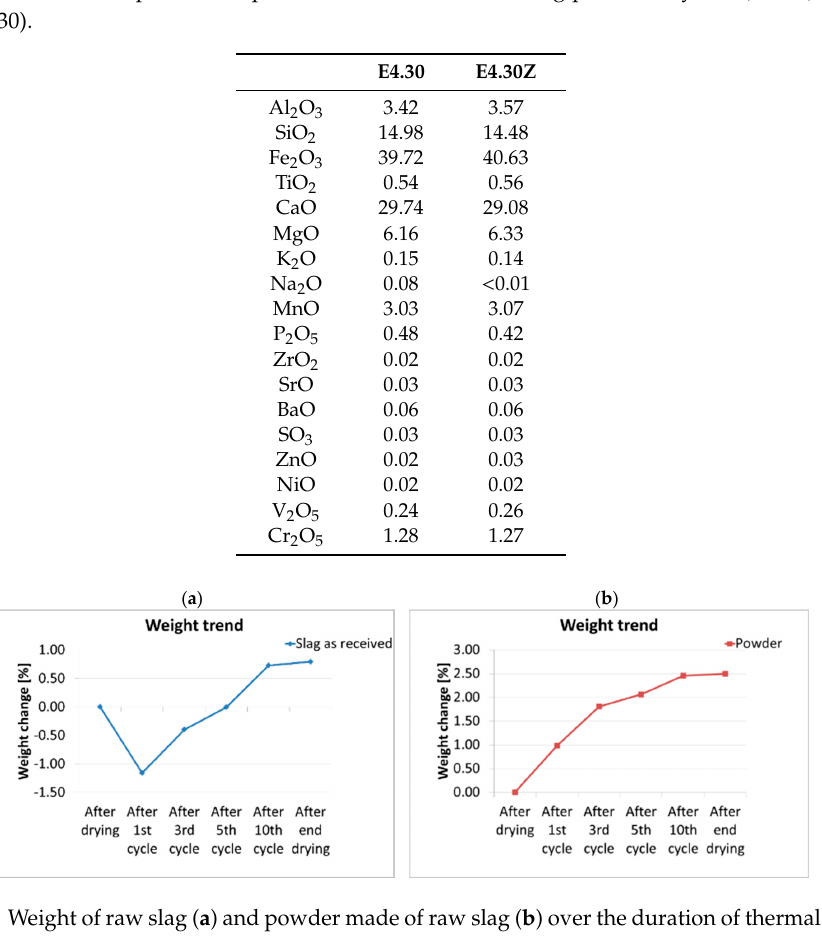
Table 8. Chemical composition of powders made of sintered slag pebbles: Cycled (E.30Z) and not cycled (E.30).